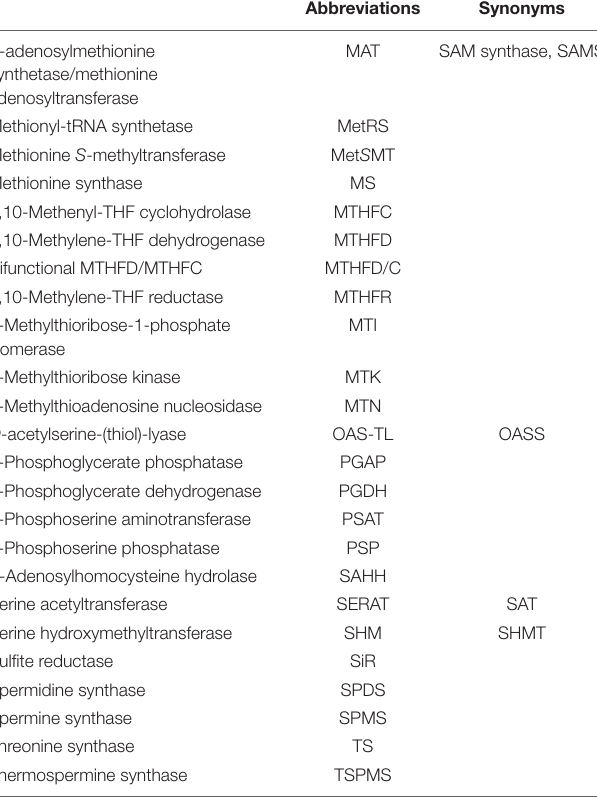
TABLE 1 | Abbreviations and synonyms used in this